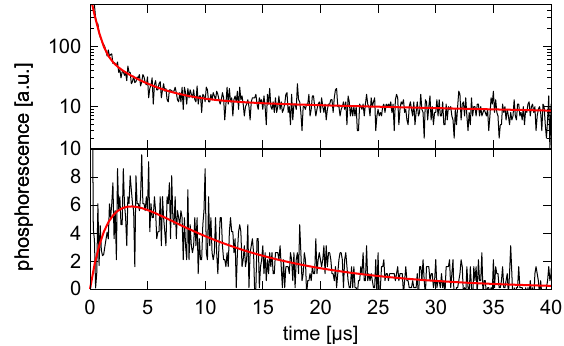
Fig. 7. Typical phosphorescence kinetics of PpIX at 910 nm approximated by combination of three exponential decays (top) and singlet oxygen at 1278 nm approximated by combination of single-exponential rise and decay (bottom).